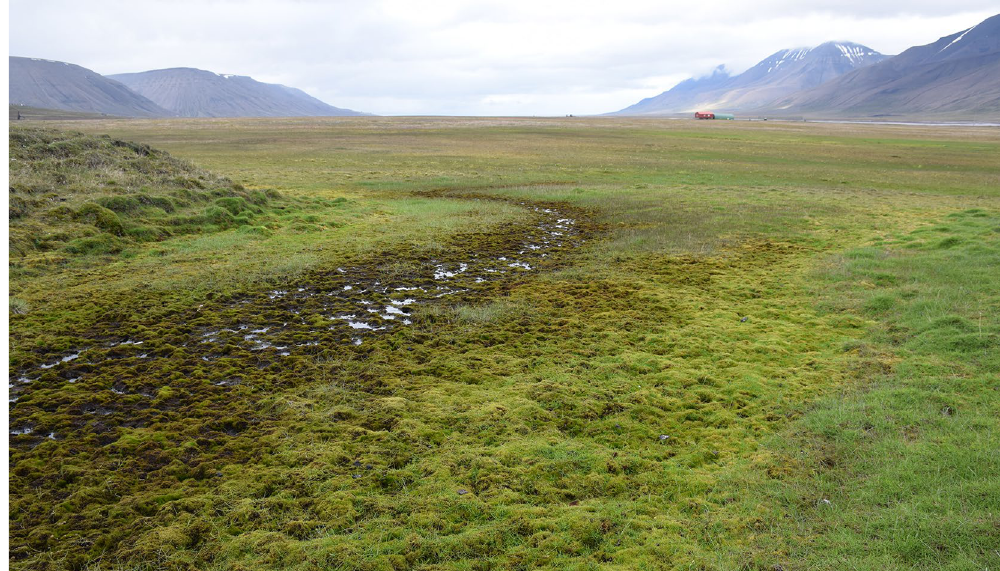
Figure 2. The general view of the Bjørndalen study site. The variations at the local scale can be seen in wet depression with mosses and dry surfaces with grass species.